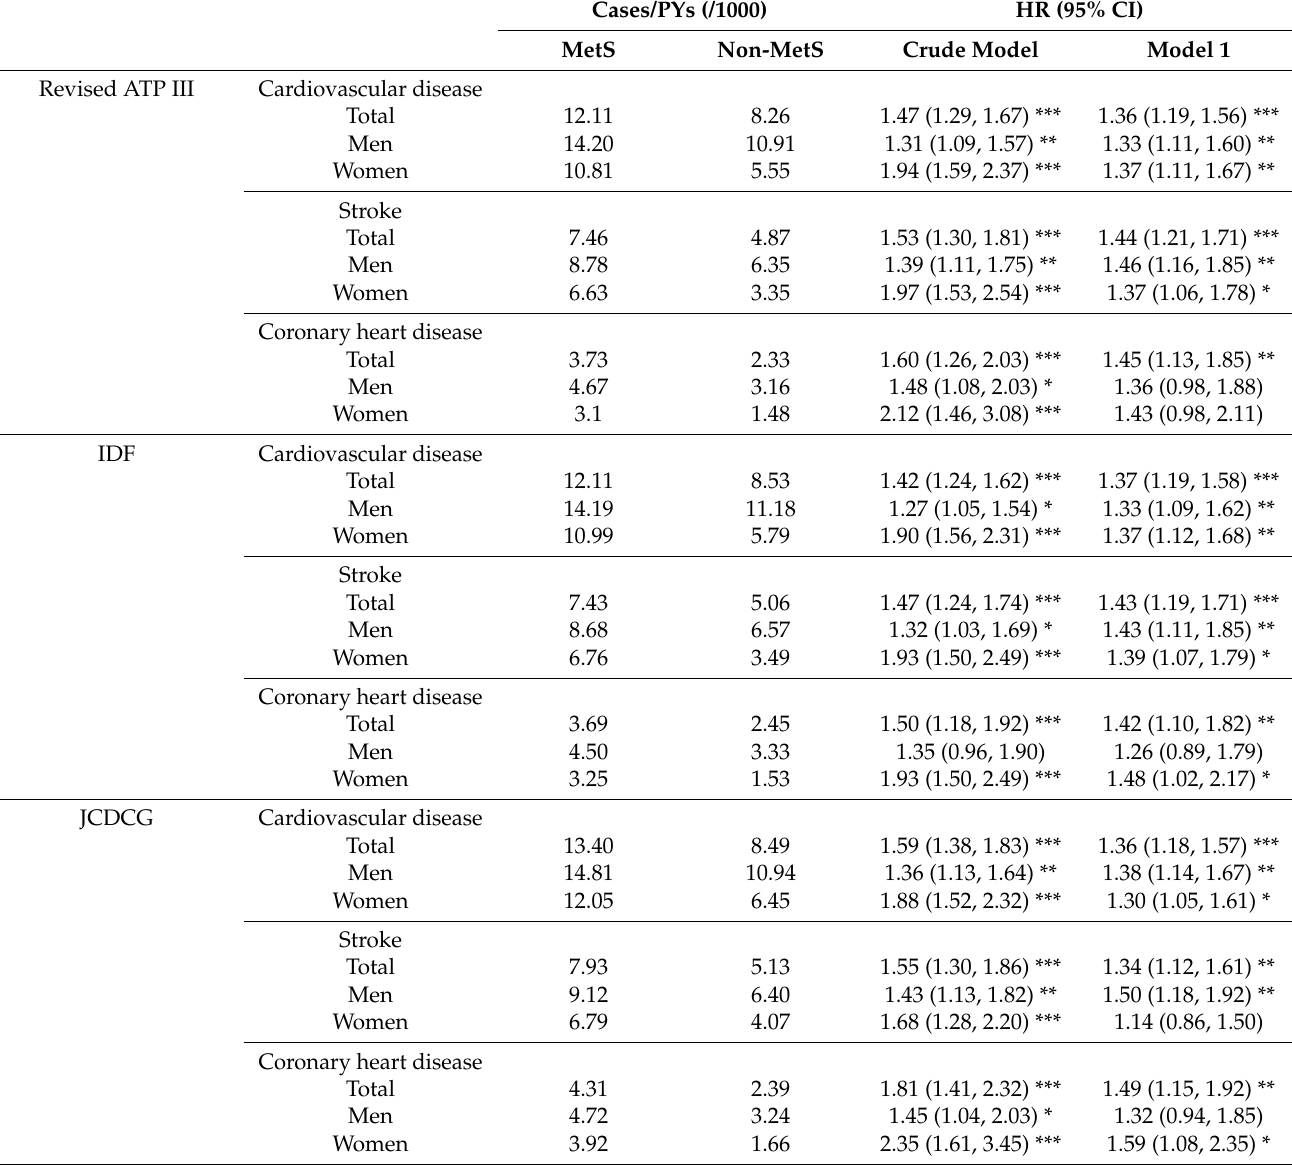
Table 3. Association of MetS defined using different criteria with the risk of cardiovascular events. Cases/PYs (/1000) HR (95% CI) MetS Non-MetS Crude Model Model